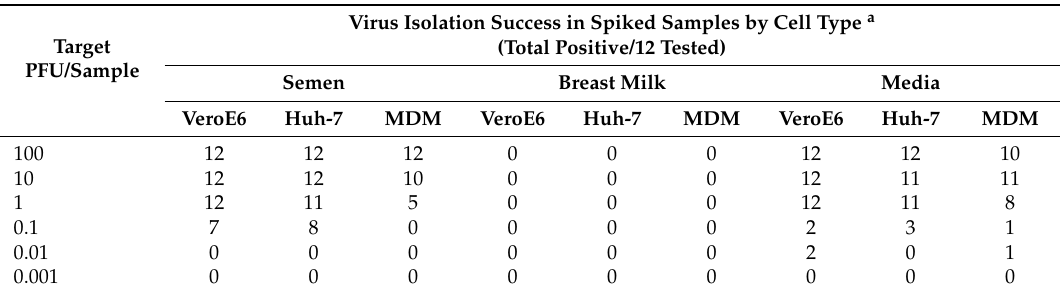
Table 4. Virus isolation success from spiked breast milk and semen samples ( n = 12). Target